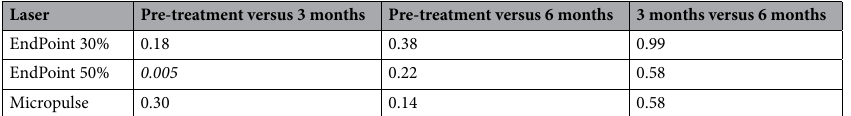
Table 1. Adjusted p-values for comparisons of foveal thickness in eyes with diabetic macular edema at different time points among three treatment groups. Statistically significant value is in italics